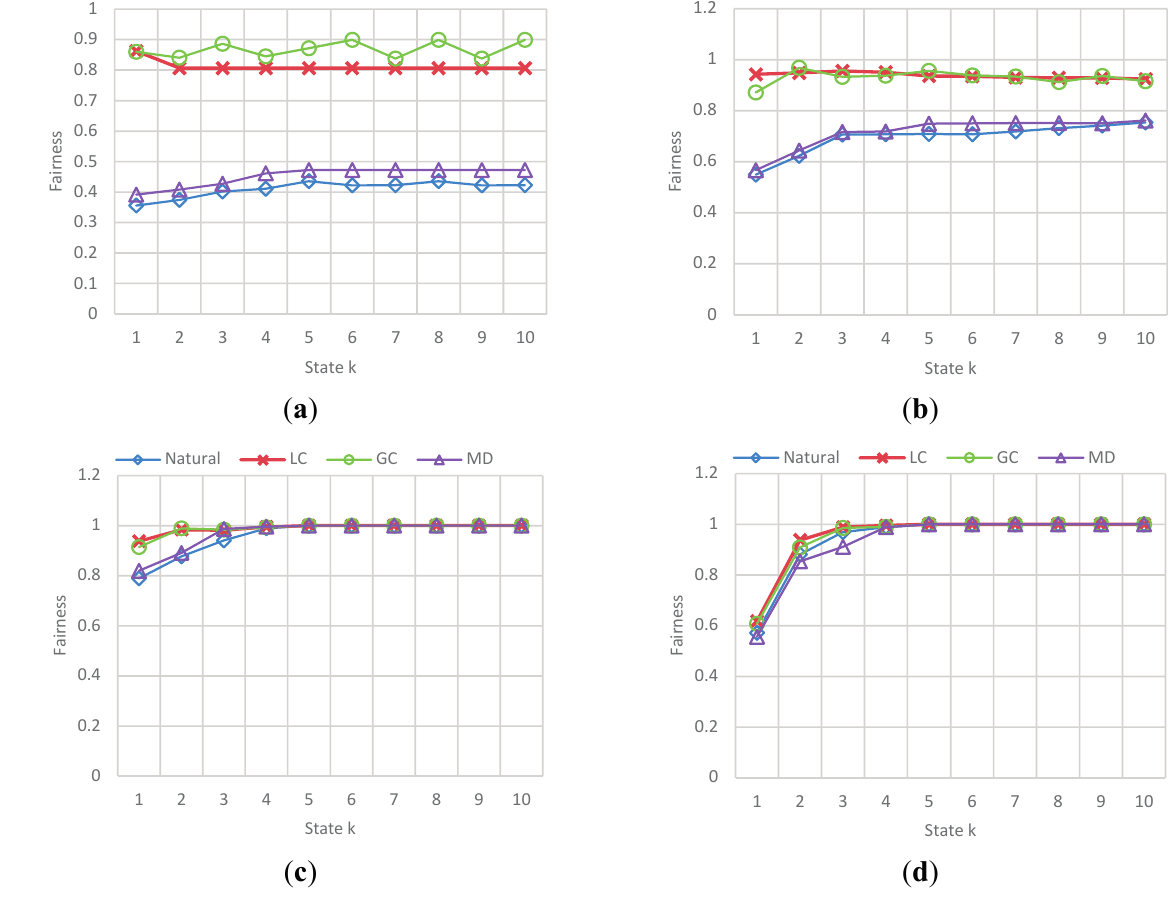
Figure 27. Obtained Fairness in a state k for each F-vehicle value. ( a ) Fairness obtained in